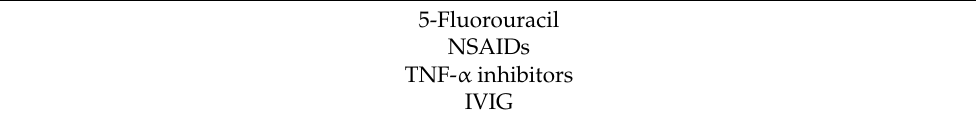
Table 3. Drugs associated with